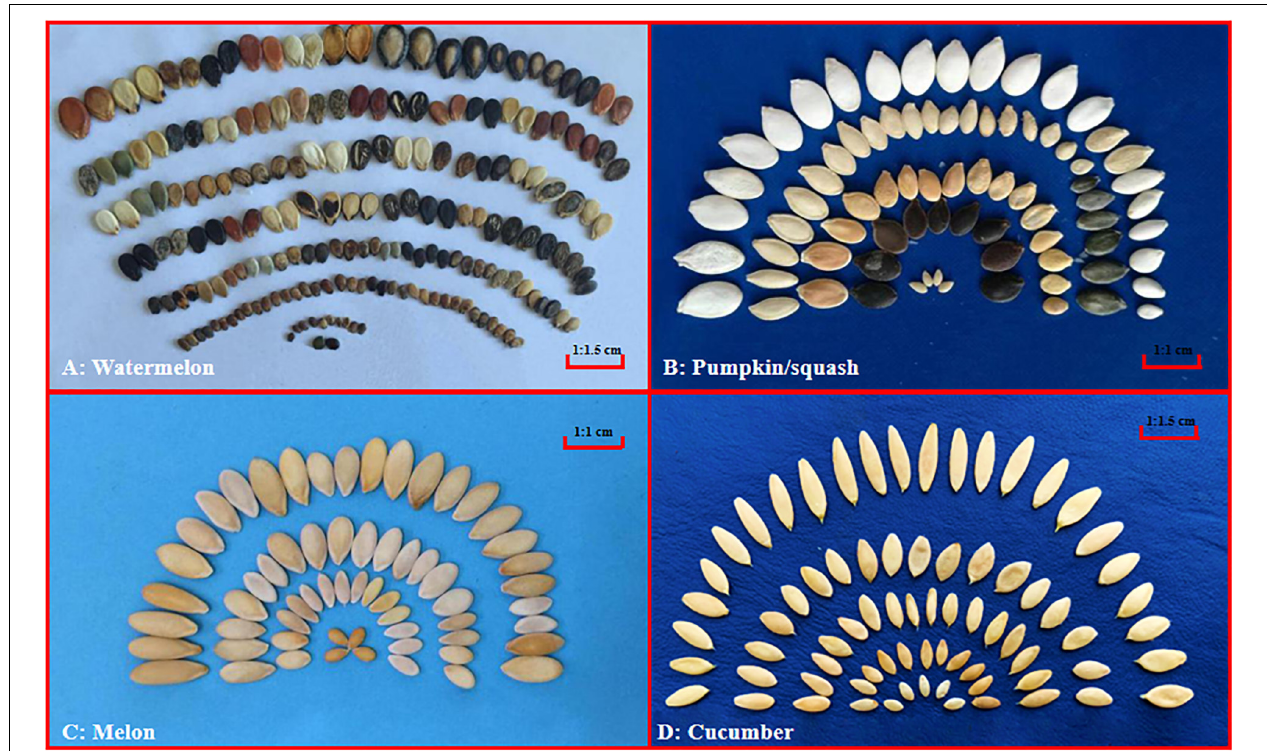
FIGURE 1 | Seed size variation among cucurbit crops. Representative seeds of watermelon ( Citrullus lanatus ), pumpkin/squash ( Cucurbita ), melon ( Cucumis melo ) and cucumber ( Cucumis sativus ) are shown in (A–D) , respectively. All images were taken by the